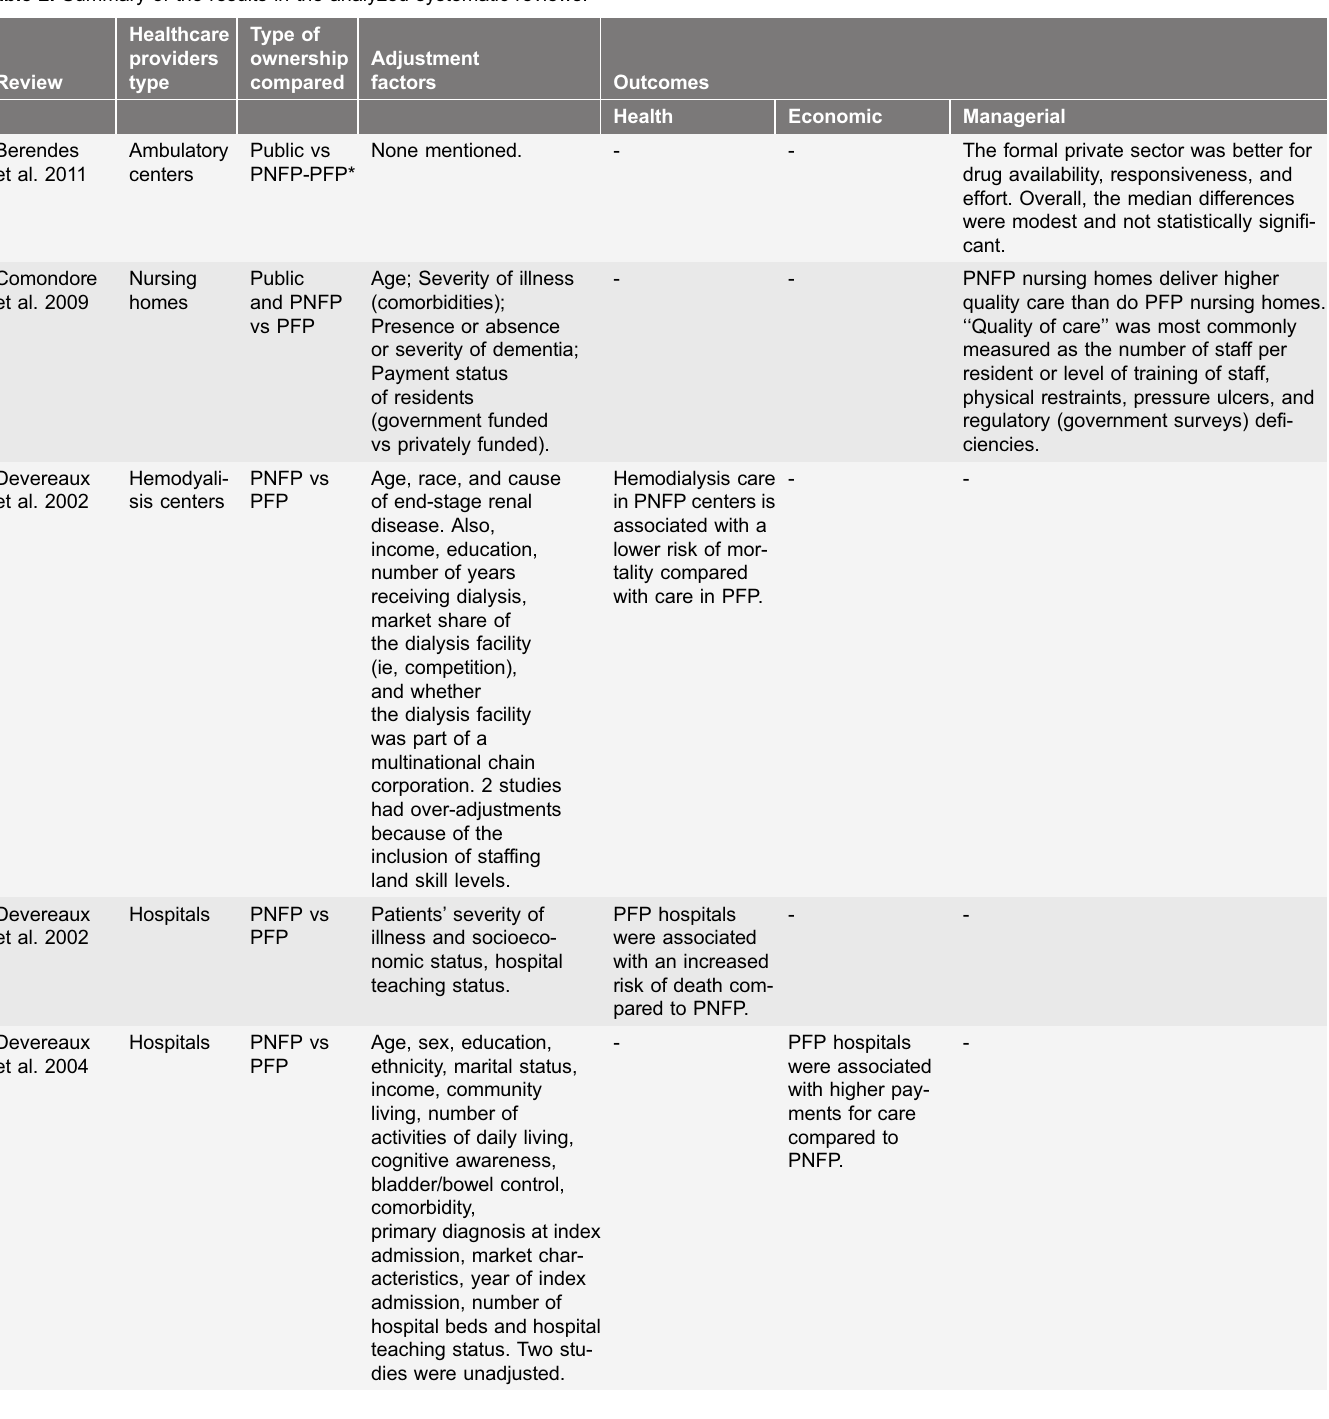
Table 2. Summary of the results in the analyzed systematic